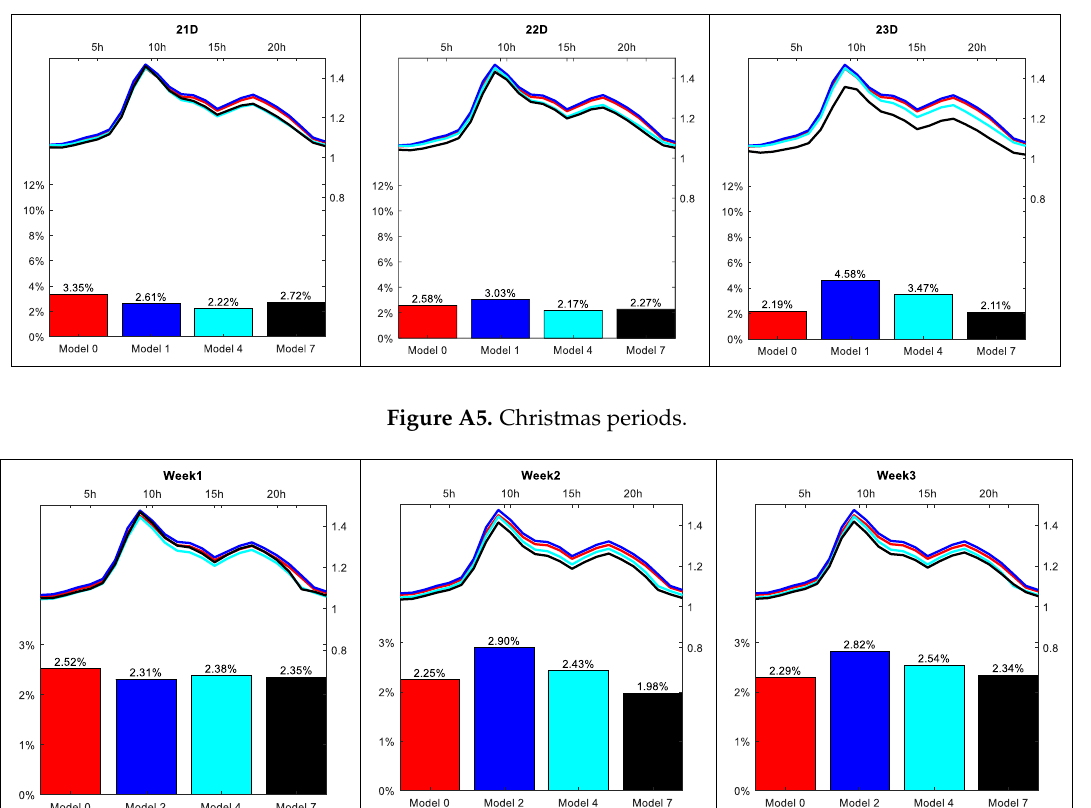
Figure A6. Summer vacation.